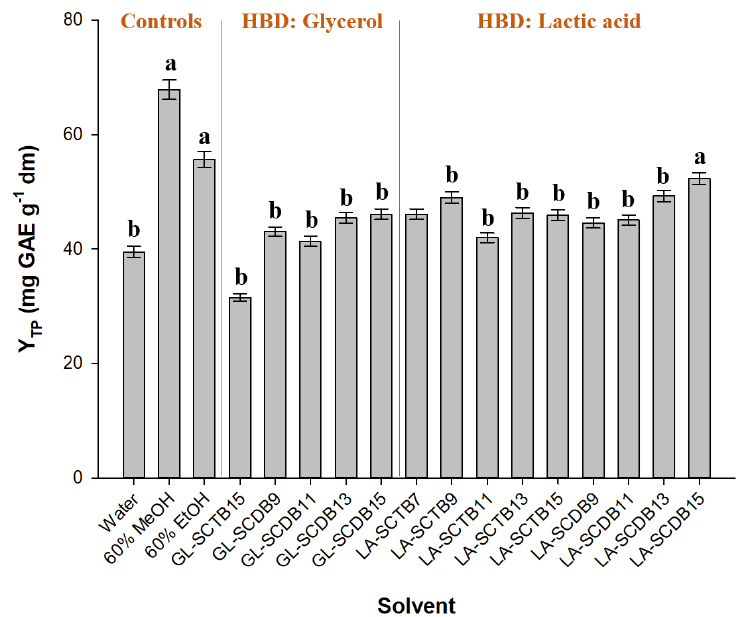
Figure 2. Graph showing the results of screening of the deep eutectic solvents (DES) tested. Extractions were accomplished at 50 °C, for 150 min, under continuous stirring at 500 rpm. All DES were tested as 70% ( w / v ) aqueous mixtures. Values designated with different letters are statistically different ( p < 0.05).